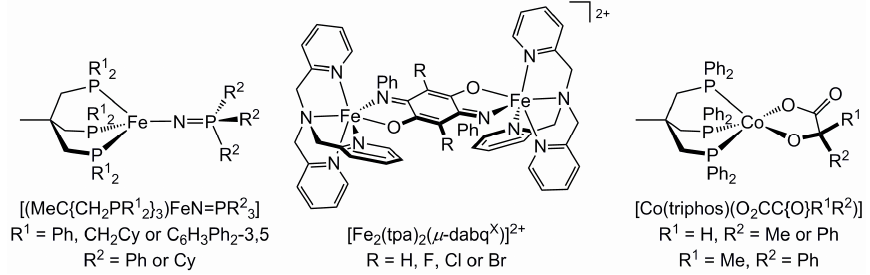
Figure 5. Two families of compounds giving contrasting linear free energy relationships between SCO T ½ and their ligand ‘R’ substituent δ P Hammett parameters from solution measurements [42,68,87]. Conversely, however, some other studies have observed the opposite trend. Most striking are three tetrahedral complexes [(PhB{MesIm} 3 )FeN=P(C 6 H 4 R) 3 ], which afforded a negative free energy relationship between T ½ and the aryl “R” substitutents in d 8 -thf solution (Figure 5) [42]. That is, the low-spin state of these complexes is stabilized by electron-donating, not electron-withdrawing, substituents. Another recent study of different tetrahedral iron(II) complexes [(MeC{CH 2 PR 12 } 3 )FeN=PR 23 ] (Scheme 8) showed a dependence of T ½ on both R 1 and R 2 , but deconvolution of steric and electronic substituent effects in that series is not so straightforward [94]. However, data from the solid dinuclear complexes [Fe 2 (tpa) 2 ( μ -dabq R )][BAr F ] 2 showed T ½ decreasing as the electronegativity of ‘R’ increases, in the order X = H > Br > Cl > F [95]. That is a similar trend to the [(PhB{MesIm} 3 )FeN=P(C 6 H 4 R) 3 ] system.